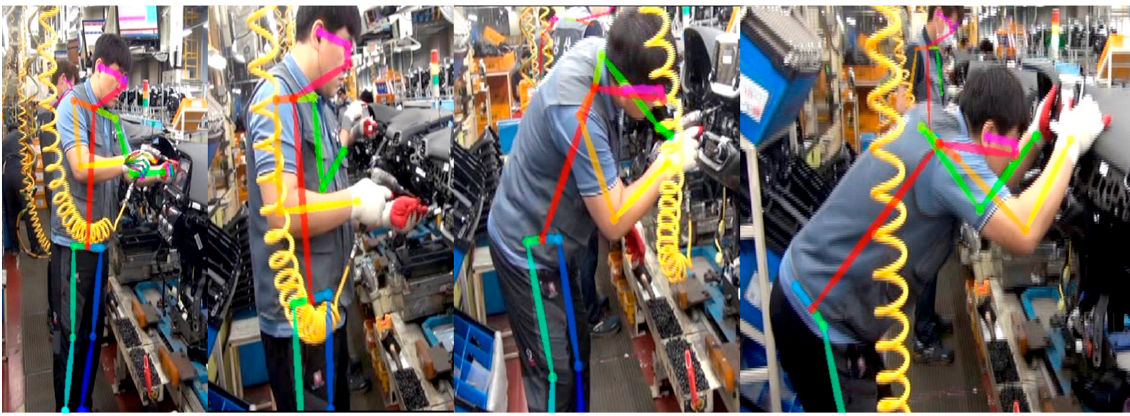
Figure 3. Results of body, foot, and hand pose estimation by OpenPose. Hand pose estimation problem due to assembly tool use with gloves on.